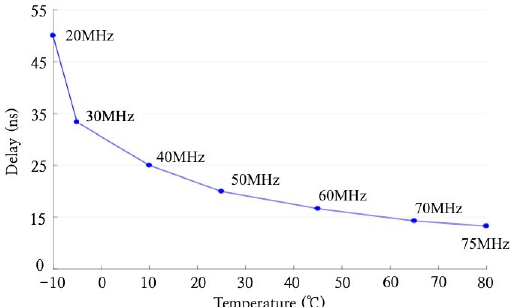
Figure 1. TEI phenomenon in a ULP-SoC fabricated in 28 nm FDSOI